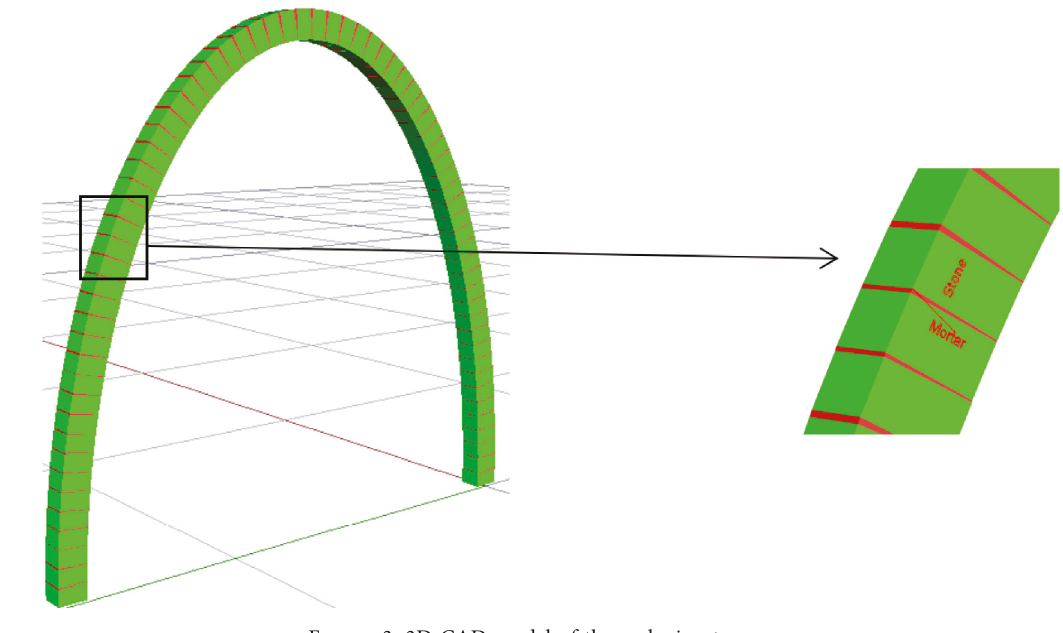
Figure 3: 3D CAD model of the arch ringstone.